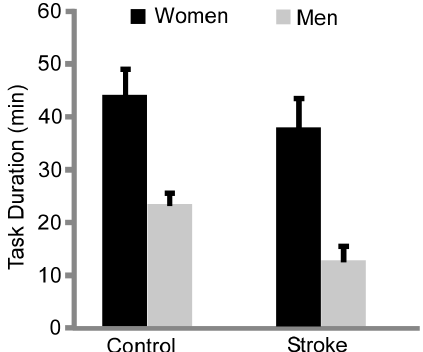
Figure 1. Task Duration. The stroke subjects had a shorter task duration compared with the control subjects (group effect, p = 0.01). Men with stroke had a shorter task duration compared to the control men and women, and women with stroke ( p ≤ 0.001).